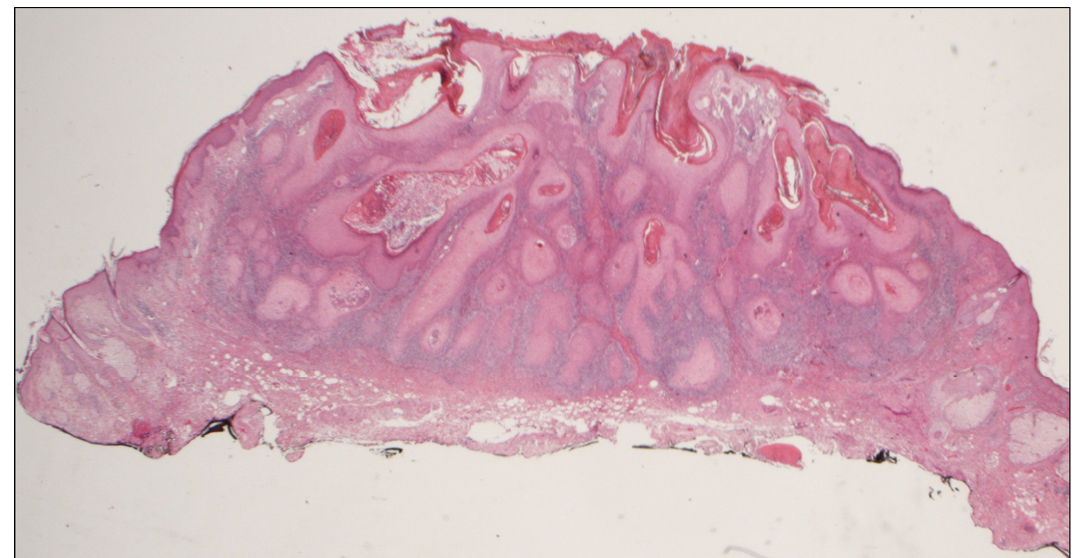
Figure 3. Histologic findings. Invasive, well-differentiated squamous cell carcinoma: keratinizing tumor infiltrating into the dermis (Hematoxylin and eosin, 2.5×).